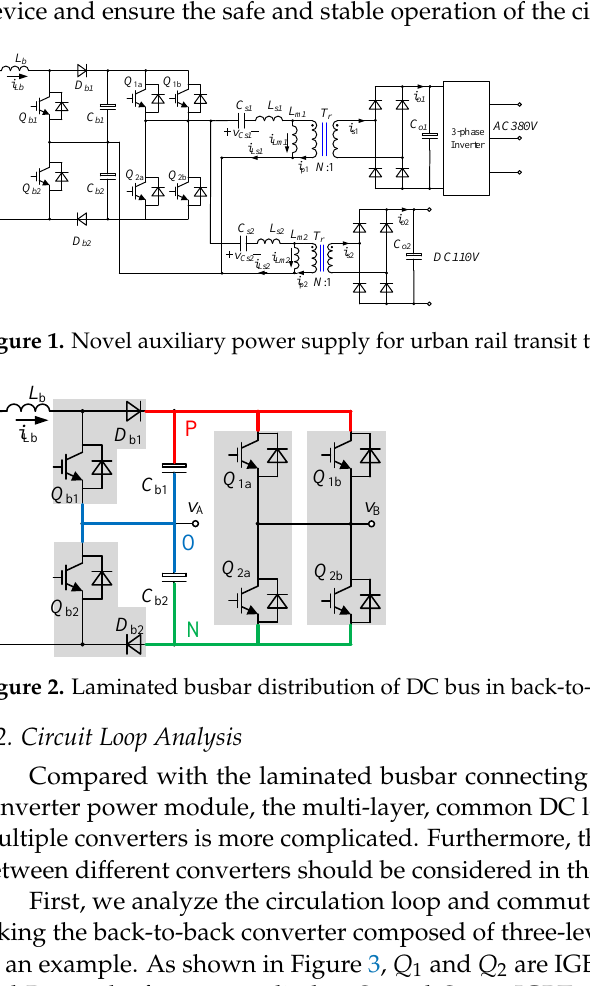
Figure 2. Laminated busbar distribution of DC bus in back-to-back converter.